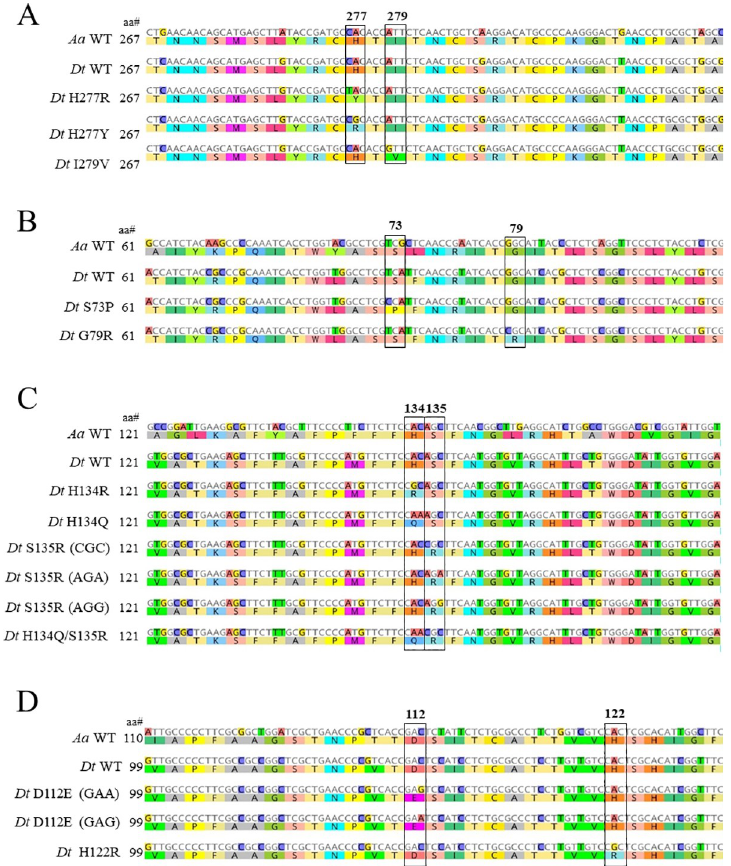
Fig 2. MAFFT alignment of partial succinate dehydrogenase gene sequences found in Didymella tanaceti ( Dt ) wild type (WT) and mutant isolates with WT sequences of Alternaria alternata ( Aa ) strain AR-SBL-4S [26] for (A) Sdh B, (B,C) Sdh C and (D) Sdh D. Reference amino acid numbers relative to each species are located to the left of the alignments. Black boxes/coloured regions indicate the amino acid substitutions found in D . tanaceti . eight isolates. At codon 88, a leucine (CTG) to methionine (ATG) substitution (L88M) occurred in four isolates. Single isolates containing either a glycine (GGC) to arginine (CGC) substitution at codon 79 (G79R) or a serine (AGC) to arginine (AGG) substitution at codon 135 (S135R) were observed (Fig 2B and 2C). A single-nucleotide polymorphism (SNP) (C/T)